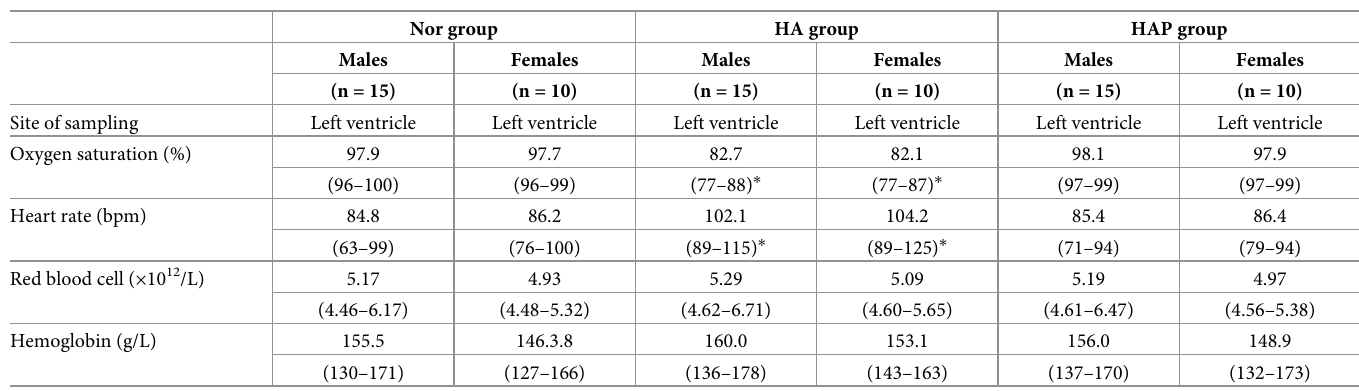
Table 1. Basic characteristics of